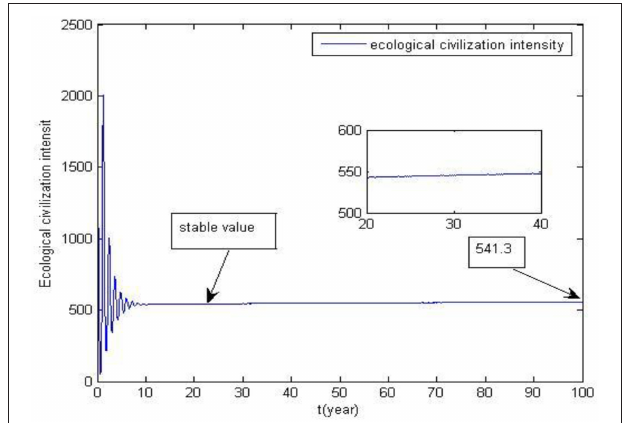
FIGURE 6 | Chart of the intensity of economic and ecological construction progress.